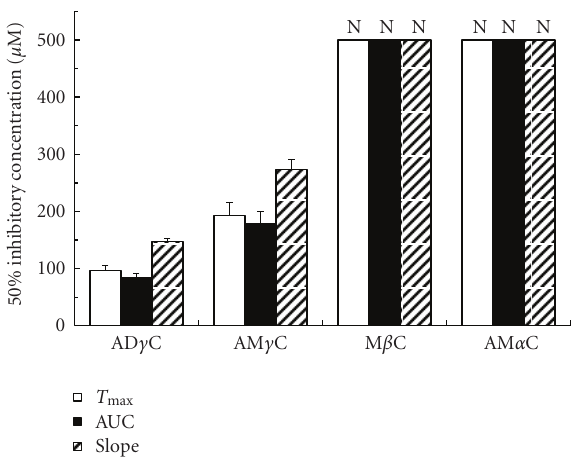
Figure 3: Concentrations of carbolines to produce 50% inhibition of the platelet aggregation responses ( T max , AUC, and slope) to PAF. N: Not inhibited by 50% at the indicated concentrations. Data are presented as mean ± SE ( n = 7).